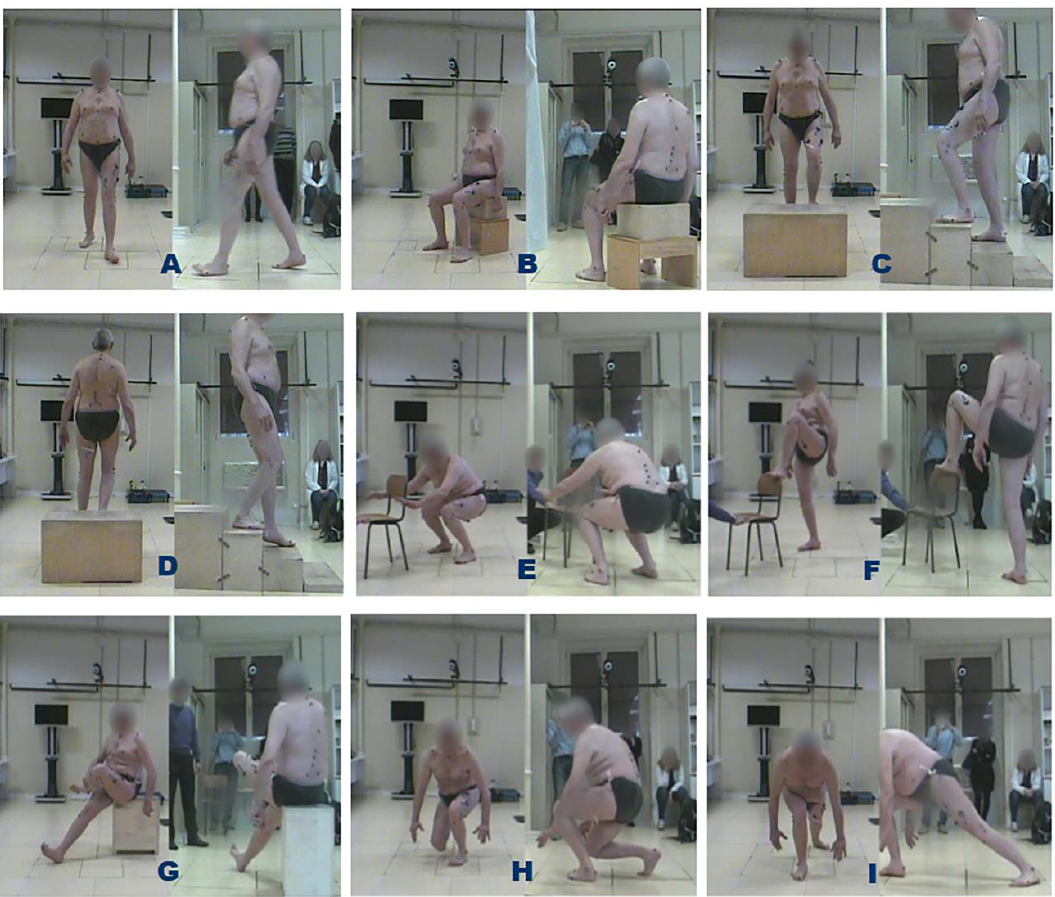
Figure 1. Images from the motor tasks performed for the gait analysis (GA), with the relevant acquisition set-up: A) Walking, B) Chair raising/sitting, C) Stair climbing, D) Stair descending, E) Squat, F) High step flexion, G) Tailor sitting, H) Lounge forward and I) Lounge backyard.